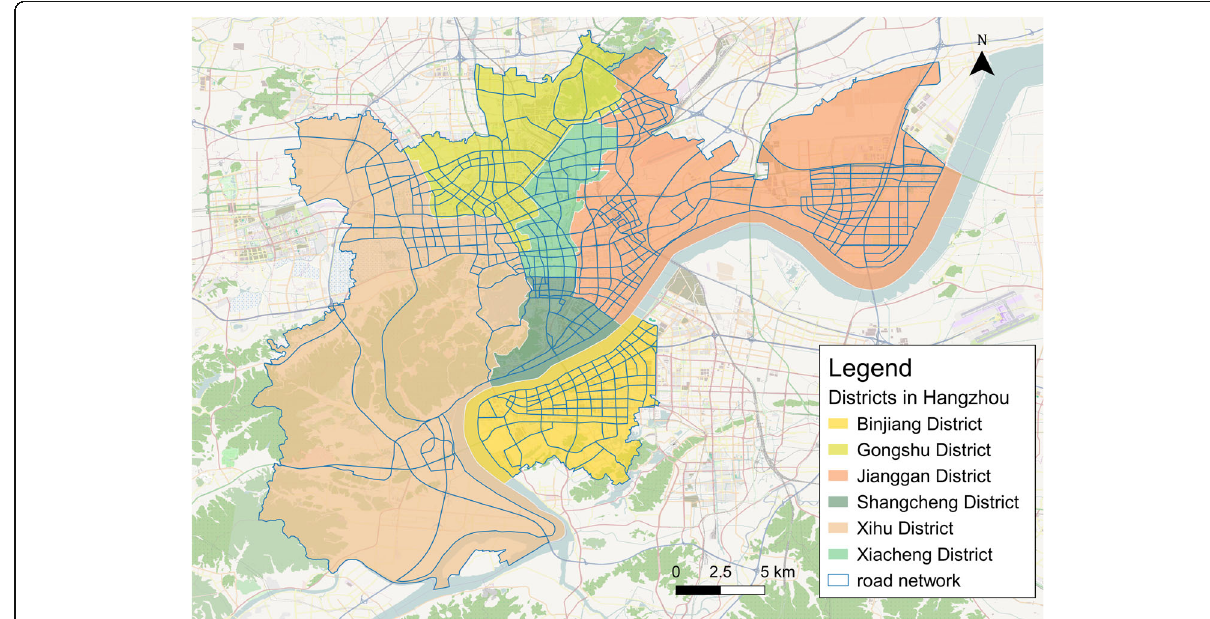
Fig. 2 Road network in the study